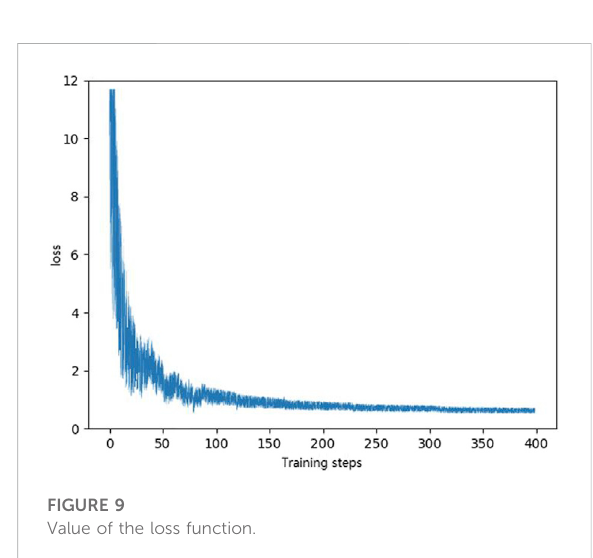
FIGURE 9 Value of the loss